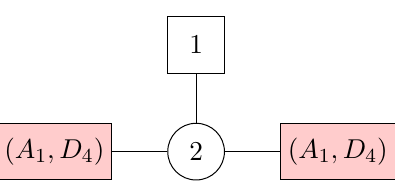
Figure 1 . The quiver diagram of the ( A 3 , A 3 ) AD theory. The left and right boxes stand for two copies of ( A ) theory while the top box stands for a fundamental hypermultiplet of SU(2) . The 1 , D 4 middle circle stands for SU(2) gauge group coupled to these